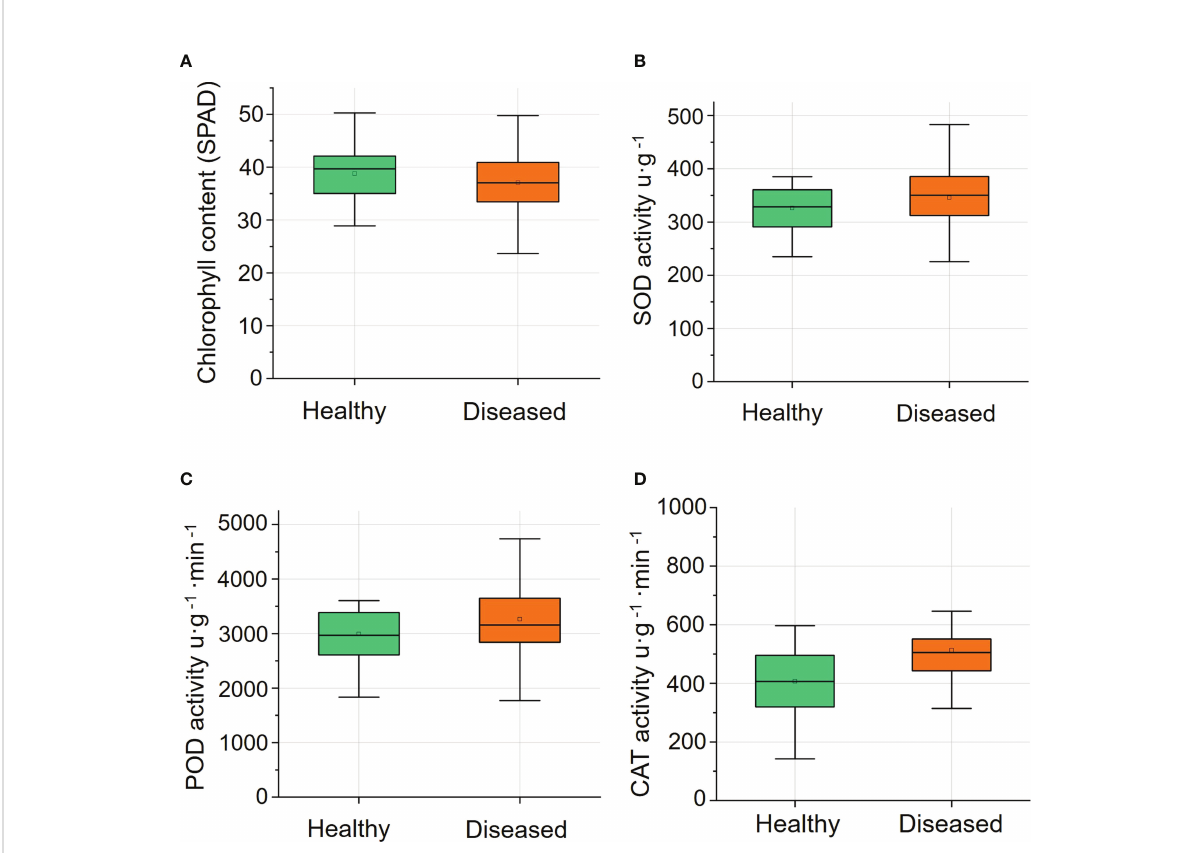
FIGURE 3 The chlorophyll content (n=57) and the activity of antioxidant enzymes (n=15) of leaves of healthy and diseased ginsengs. (A) Changes of relative chlorophyll content in healthy and diseased ginseng. (B) Changes of SOD activity in healthy and diseased ginseng. (C) Changes of POD activity in healthy and diseased ginseng. (D) Changes of CAT activity in healthy and diseased ginseng. SPAD, soil plant analysis development; SOD, superoxide dismutase; POD, peroxidase; CAT,